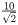
Bland-Altman plot for depicting the agreement between NGS and Sanger sequencing heteroplasmy measurements.On the x-axis, the average of next-generation and Sanger sequencing heteroplasmy estimates is plotted. On the y-axis, the difference between next-generation and Sanger sequencing heteroplasmy estimates is plotted. The mean difference is indicated as green line, the 95% limits of agreement (average difference ± 1.96 standard deviation of the difference) are indicated as red dotted lines. For heteroplasmies 10%, which were detected with NGS, but could not be found in Sanger electropherograms, the value for the Sanger estimation was set to 102.